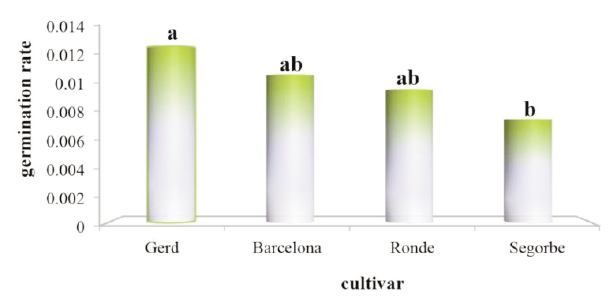
fig. 6 - Seed germination rates in four hazelnut